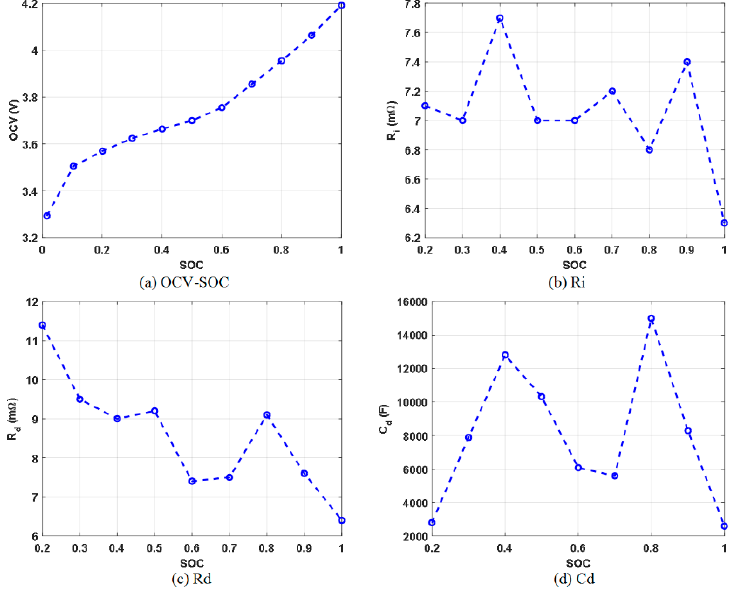
Figure 9. Open circuit voltage (OCV) and other parameters of the battery’s cell with respect to SOC.